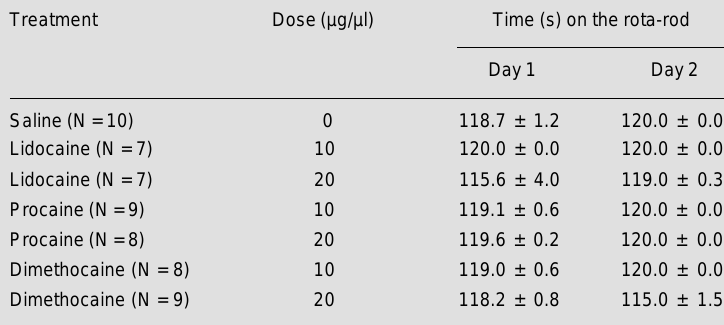
Table 1 - Influence of local anesthetics injected icv immediately after the session on day 1 on the ability of male mice to remain on the